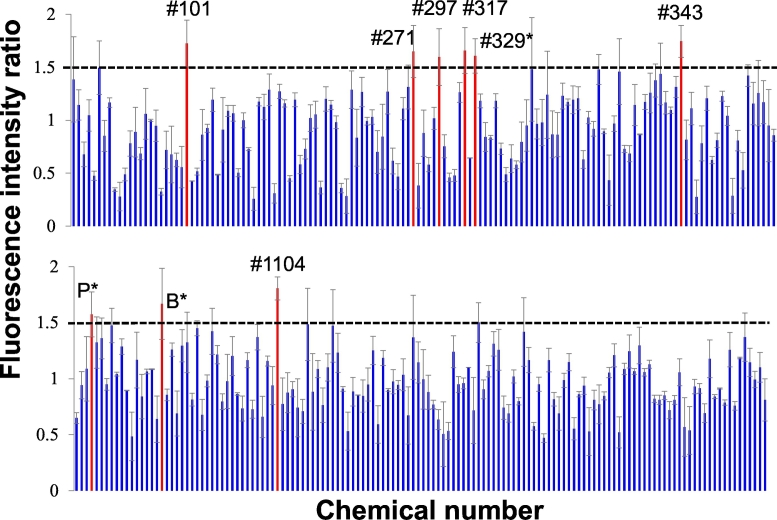
The results of analyses of the change in PLP1-EGFP intensity in the whole cell with chemicals, ratios of the whole-cell EGFP fluorescence intensity in MO3.13 cells stably expressing PLP1A243V 24 h before/after adding 275 chemicals analyzed by an In Cell Analyzer 1000® are shown. Each ratio is the result of averages from an analysis of each of three biological replicates with an In Cell Analyzer® and has been corrected by the ratio of control cells (analyzed at the same two points, with addition of the same amount of solvents for each chemical). Chemicals that showed a > 1.5-fold fluorescence intensity are highlighted in red. Error bar: mean ± standard error (SE). #101, apomorphine; #271, vincamine; #297, benzydamine; #317, guanethidine; #329, tacrine; #343, desipramine; P, piracetam; B, benserazide; #1104, clonixin lysinate. The chemical number denoted by an asterisk means that the fluorescence intensity with the concerned chemical shows a P-value <.05 compared with control. For these 9 chemicals, all chemicals were dissolved by DMSO, with the exception of vincamine, which was dissolved by chloroform. (For interpretation of the references to colour in this figure legend, the reader is referred to the web version of this article.)